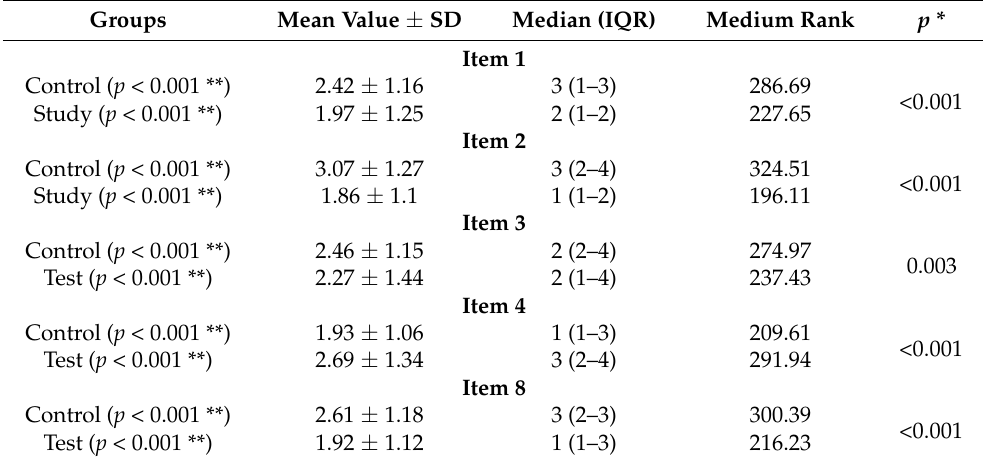
Table 9. Comparison of answers provided for Items 1, 2, 3, 4, and 8 according to the analyzed groups. Groups